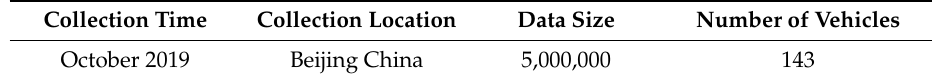
Table 3 indicates the time, location and size of data. Table 3. The general information about the